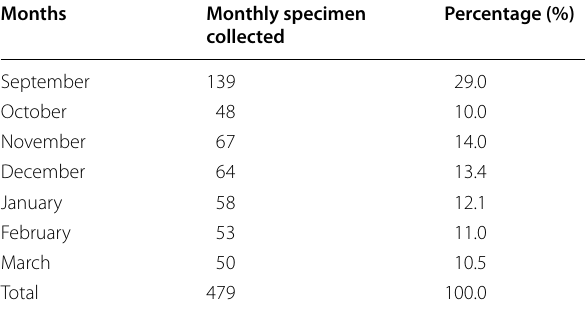
Table 1 Monthly collection of Charybdis callianassa from